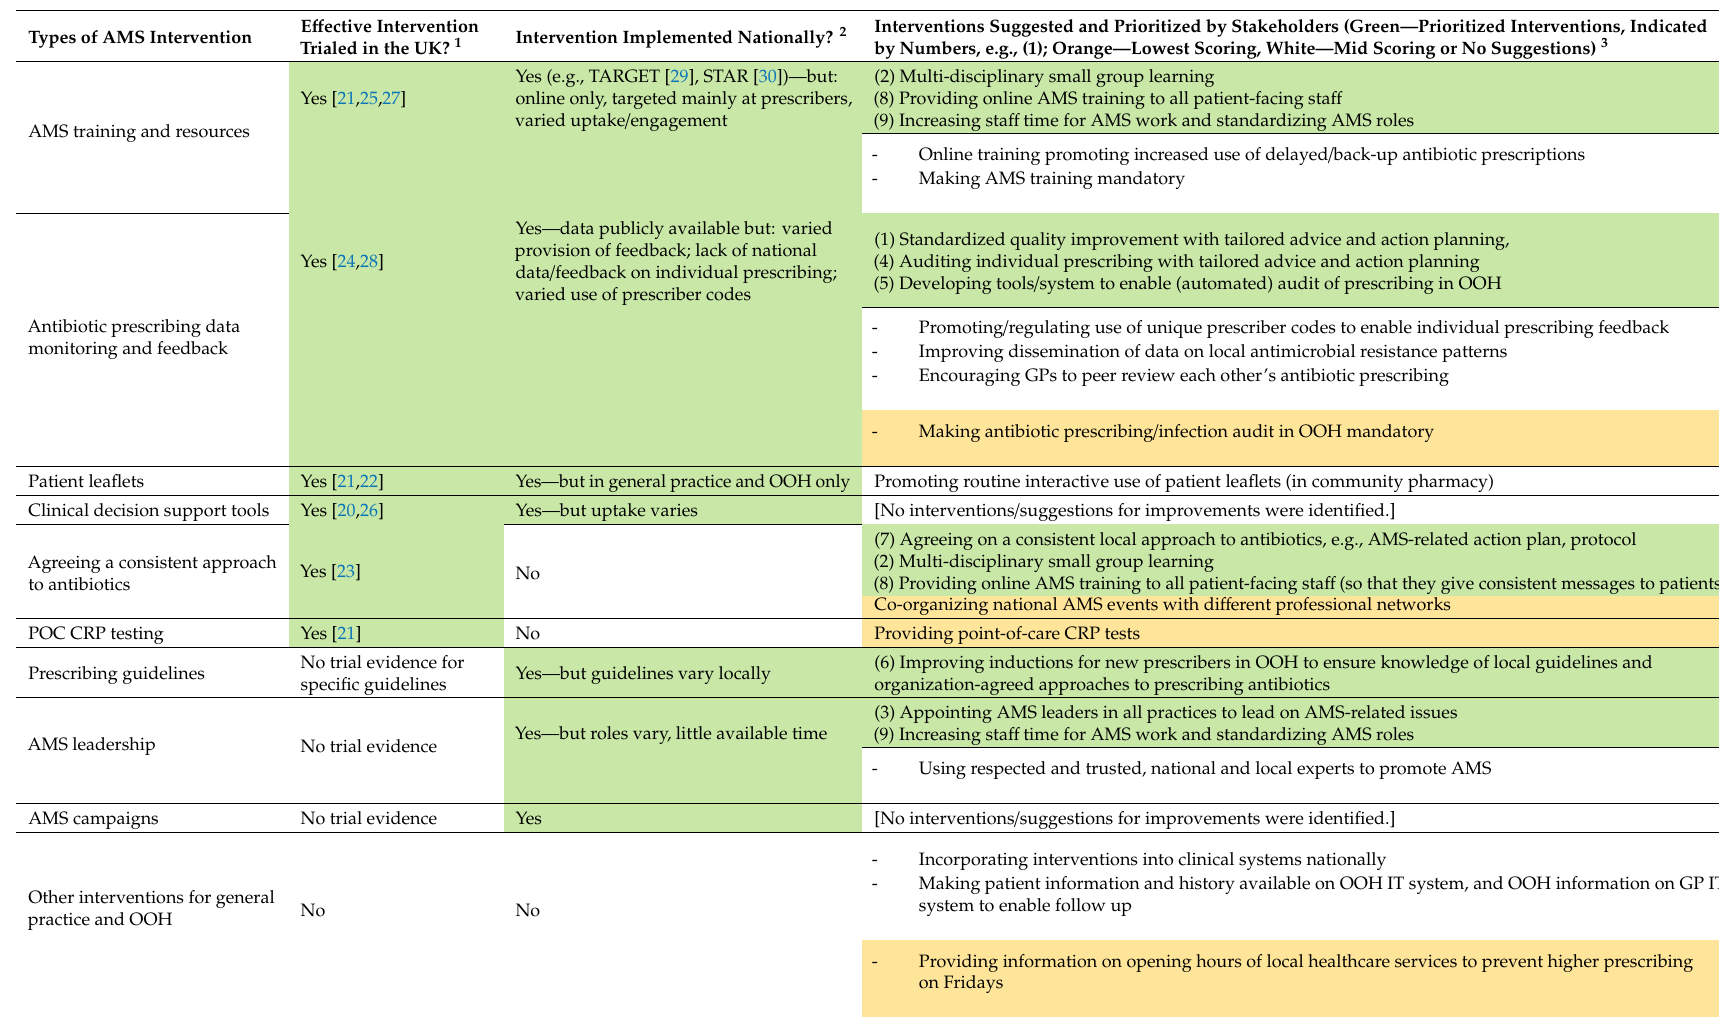
Table 3. Proposed AMS interventions and how they fit with current research and